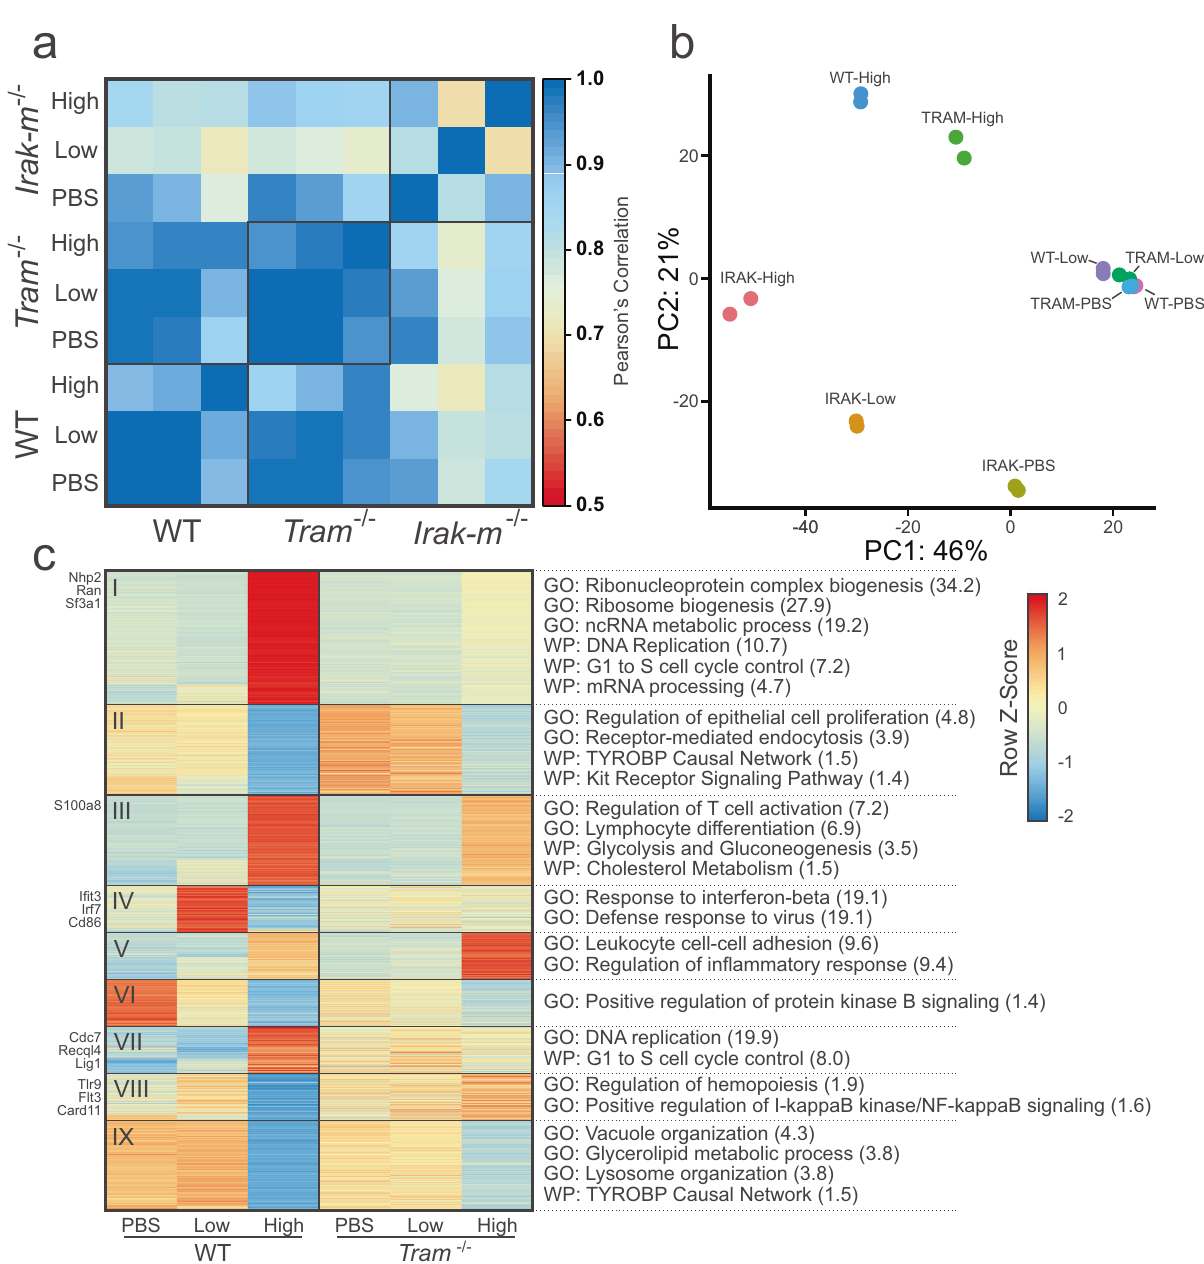
Fig. 6 Effect of TLR4 pathway on LPS-dosage response. a Pearson ’ s correlation of RNA-seq signal between conditions. b Principle Component Analysis of replicates using top 500 variable genes. c Heatmap of WT and TRAM-de fi cient gene expression at varied LPS-dosage using DEGs from the WT comparisons. Signi fi cant pathways on right are from Gene Ontology or WikiPathways. Log(FDR) for each in